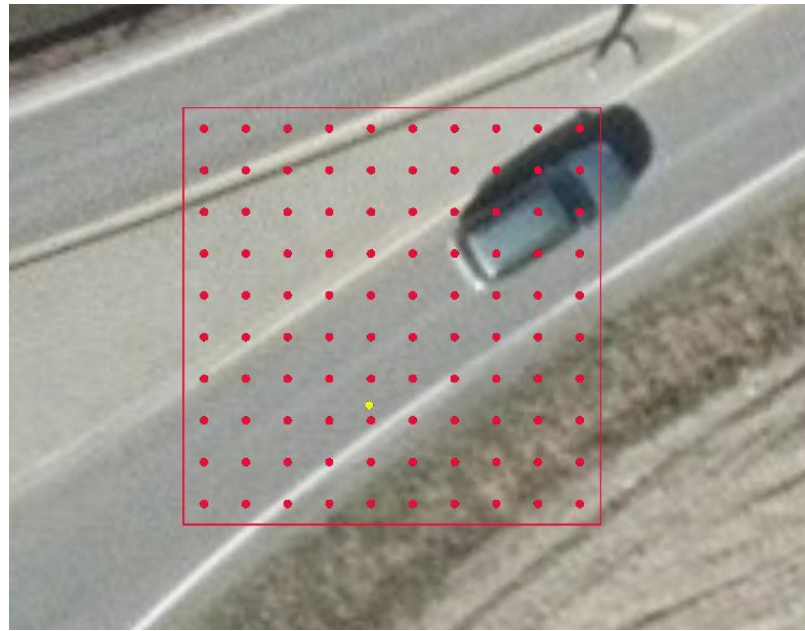
Figure 1. A 10 m pixel in HRL IMD with 100 sample points (red dots). The yellow dot shows the original random sample point used to detect and include this pixel. Photo obtained during the summer of 2017. Data source: © Norge i bilder/Norge digitalt.